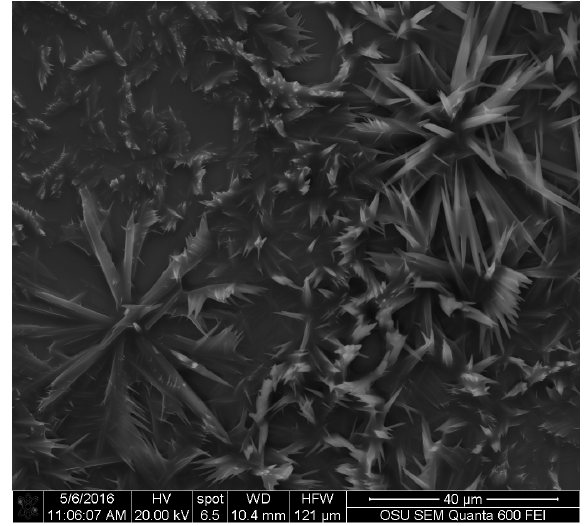
Figure 4. Crystal like structures from the extracted pigment of S. cuboideum . Picture taken with an FEI QUANTA 600 F.